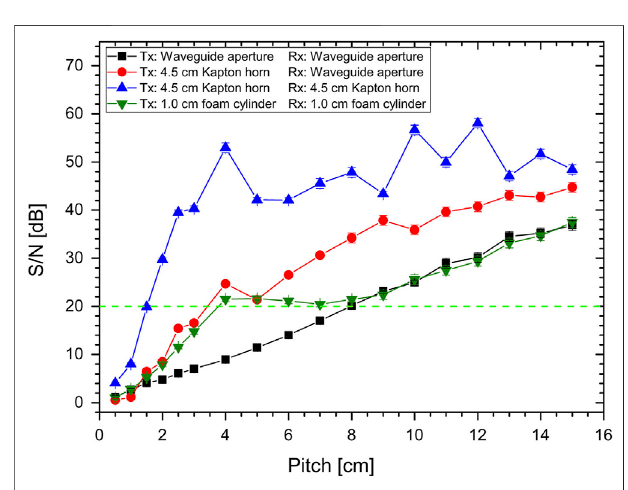
FIGURE 7 | S/N in the radio frequency spectrum with LOS induced crosstalk as function of the antenna pitch for different setups